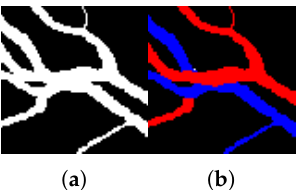
Figure 4. An example of ( a ) binary vessel segmentation and ( b ) AV classification on arteries (red) and veins (blue) that are parallel and touching each